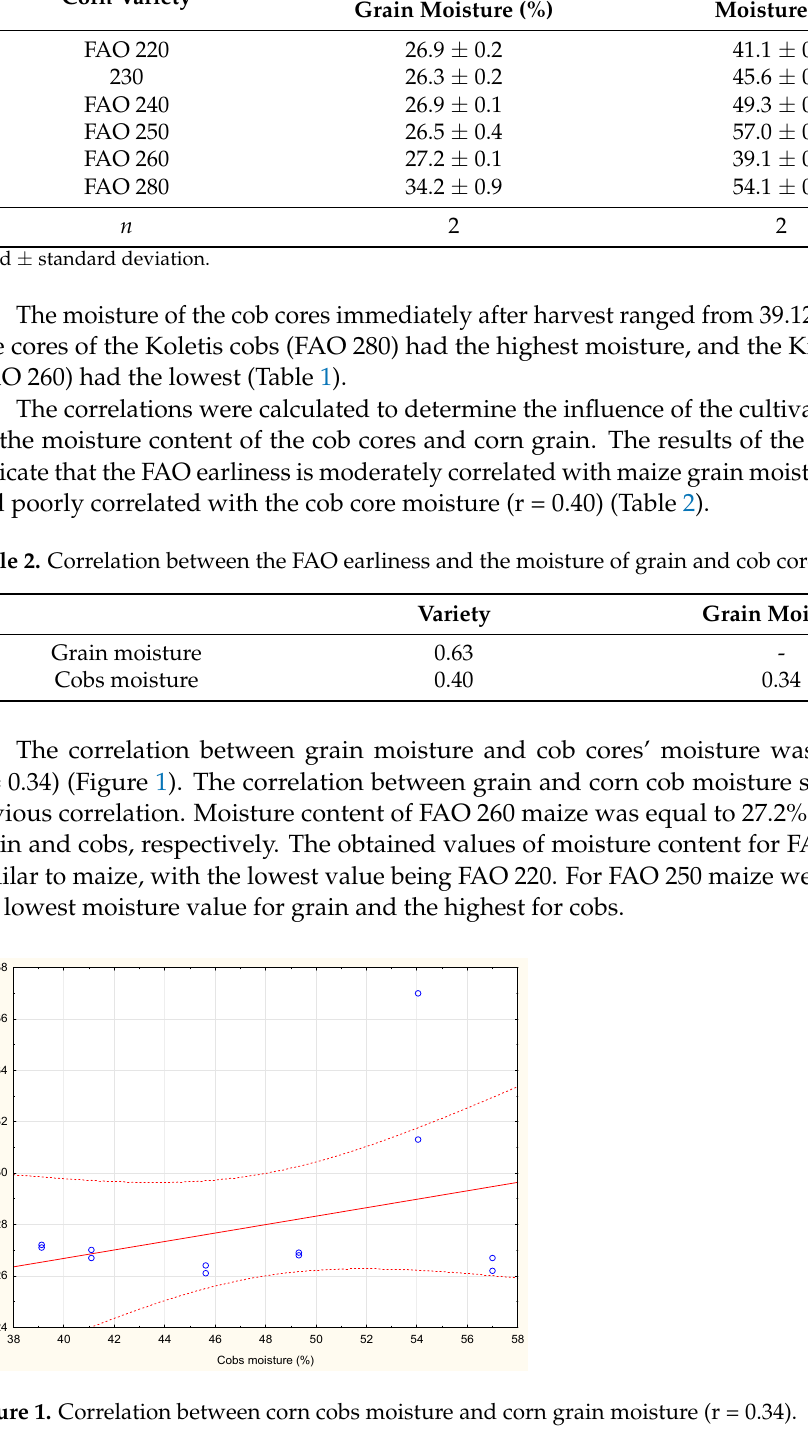
Table 1. Average moisture content of grain and corn cob cores at harvest. Corn Variety